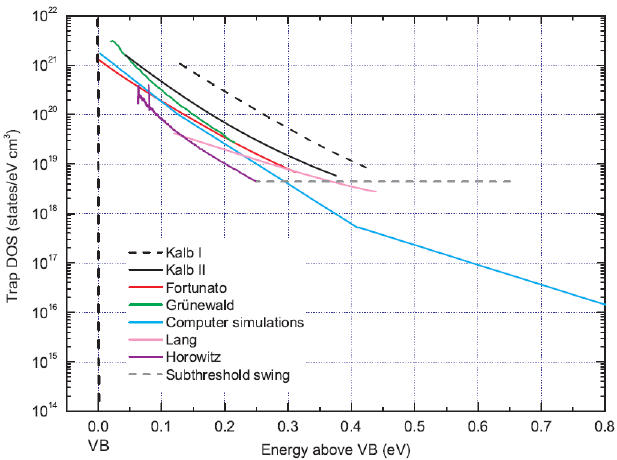
Figure 8. Comparison of the interfacial trap DoS obtained for pentacene thin-film transistors using several analytical and numerical methods. Reproduced with permission [64]. Copyright © 2010, American Physical Society.